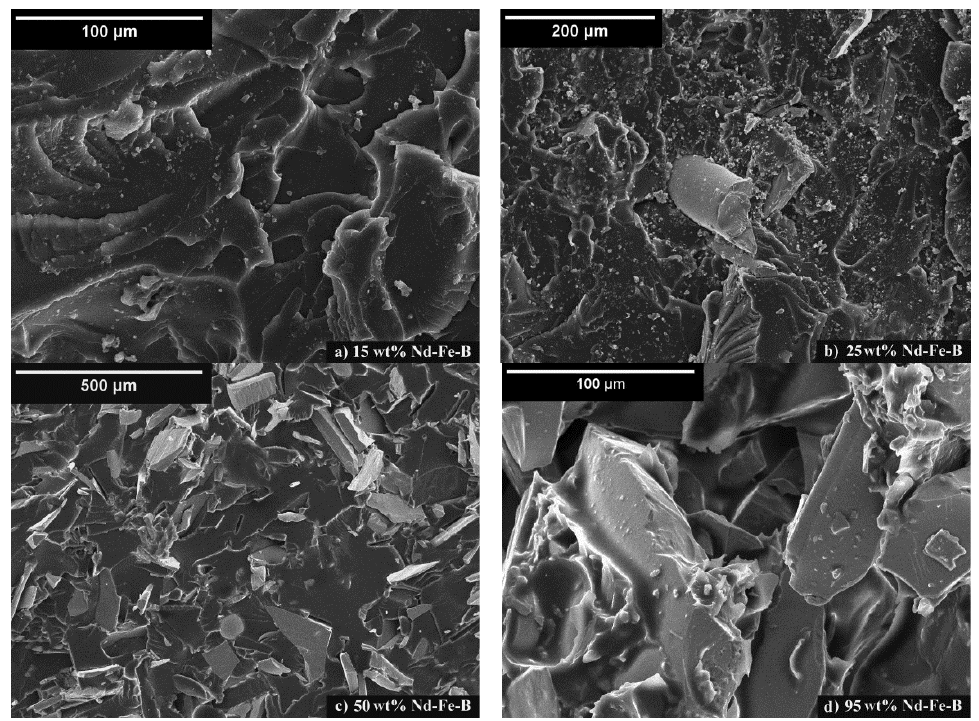
Figure 8. SEM images of the fracture surface of composites with ( a ) 15 wt.%, ( b ) 25 wt.%, ( c ) 50 wt.%, and ( d ) 95 wt.% of Nd-Fe-B magnetic particles in epoxy matrix.